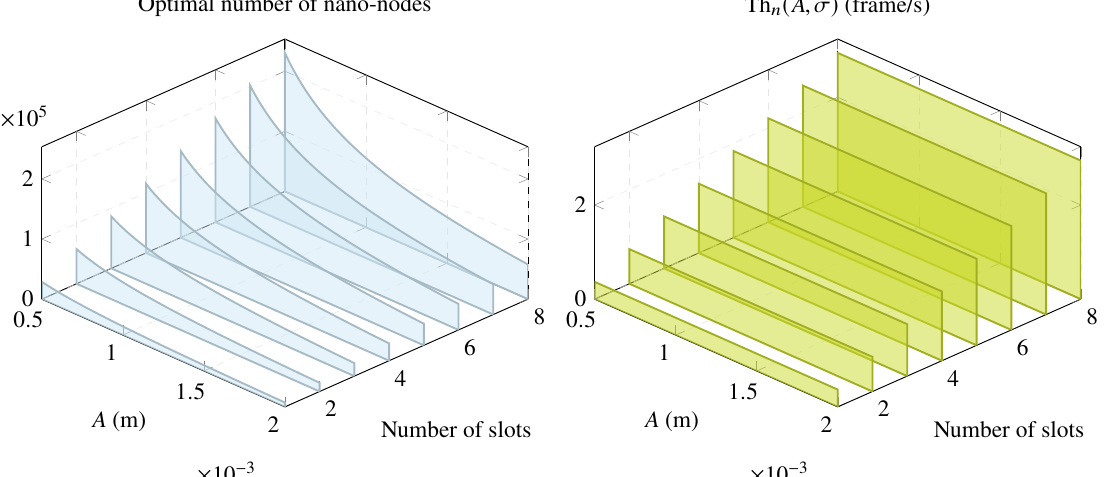
Figure 5. Relation between the optimal number of nano-nodes and the maximum achievable network throughput for f = 1Hz, v = 0.24m / s, T = 60s, and t f = 0.